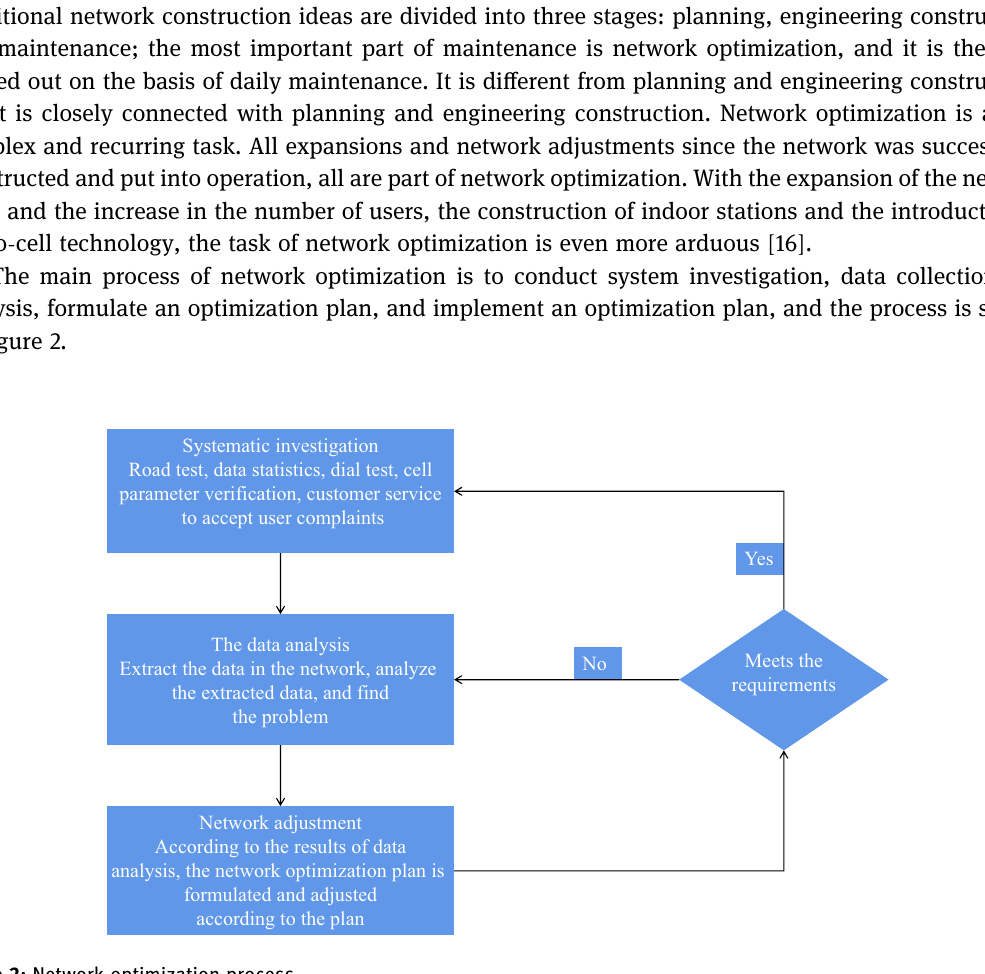
Figure 2: Network optimization process.